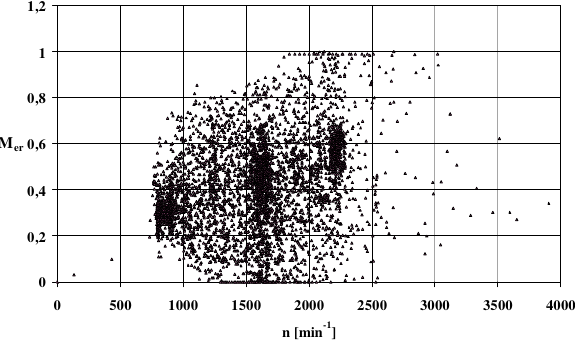
Fig. 8. A set of points in coordinates of engine rotational speed–relative torque in the Malta test